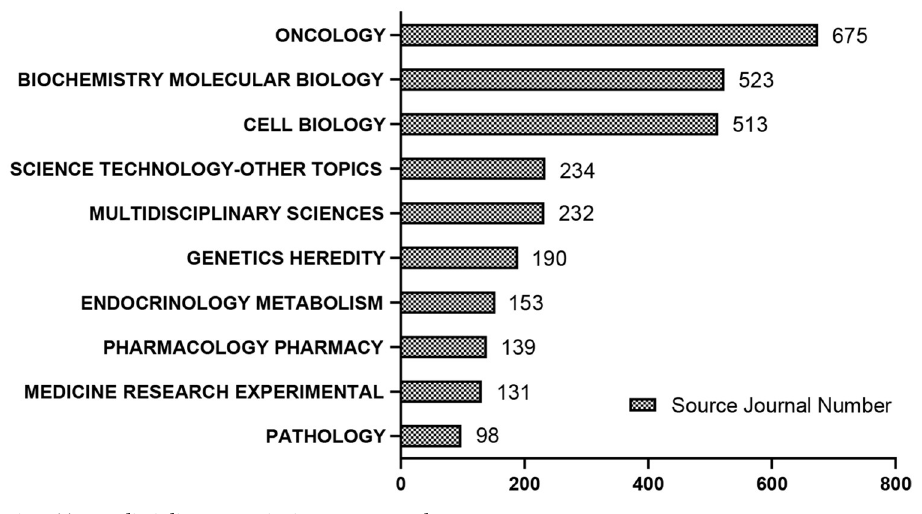
Fig 3. Top 10 discipline categories in LKB1 research.